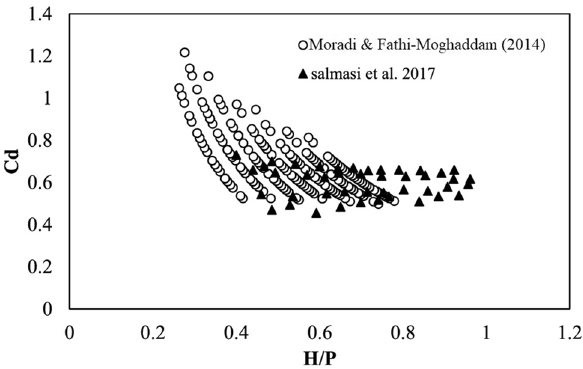
Fig. 2 Experimental C d extracted from (Moradi and Fathi- Moghaddam 2014) and Salmasi et al. (2017)